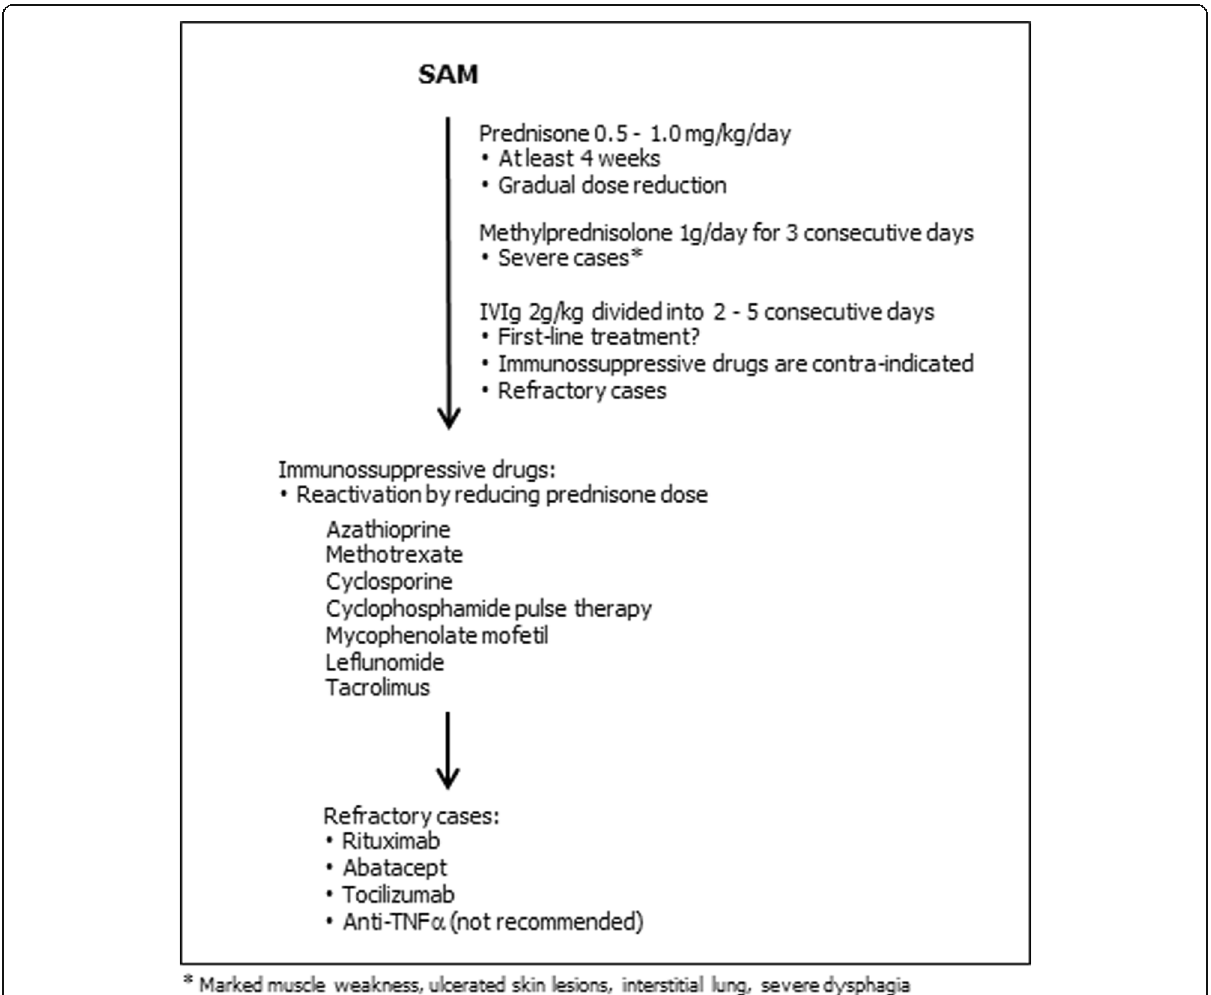
Fig. 1 A flowchart showing the recommended therapeutic approach stratified for preferred drugs, according to the